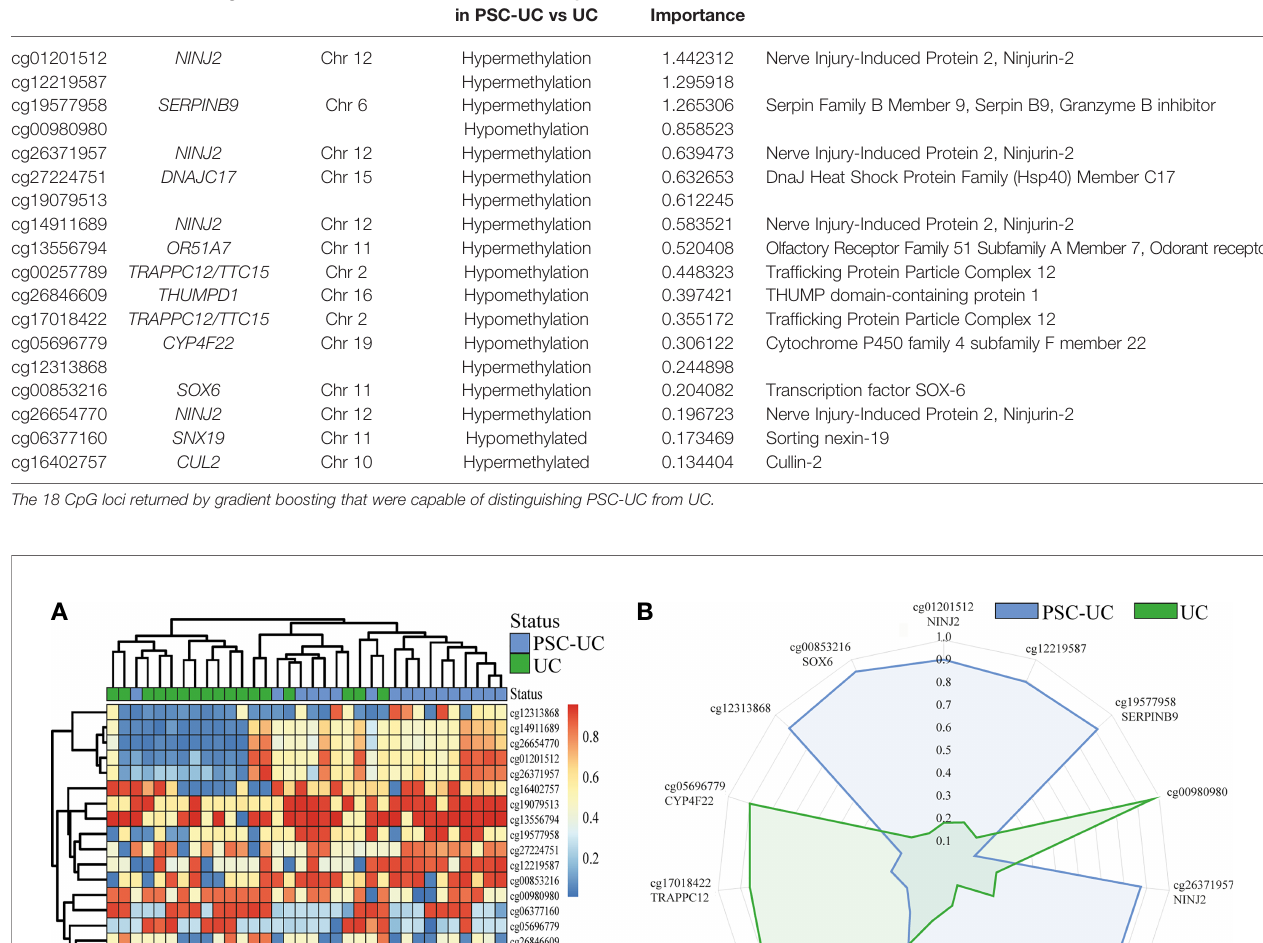
Feature in PSC-UC vs UC Importance